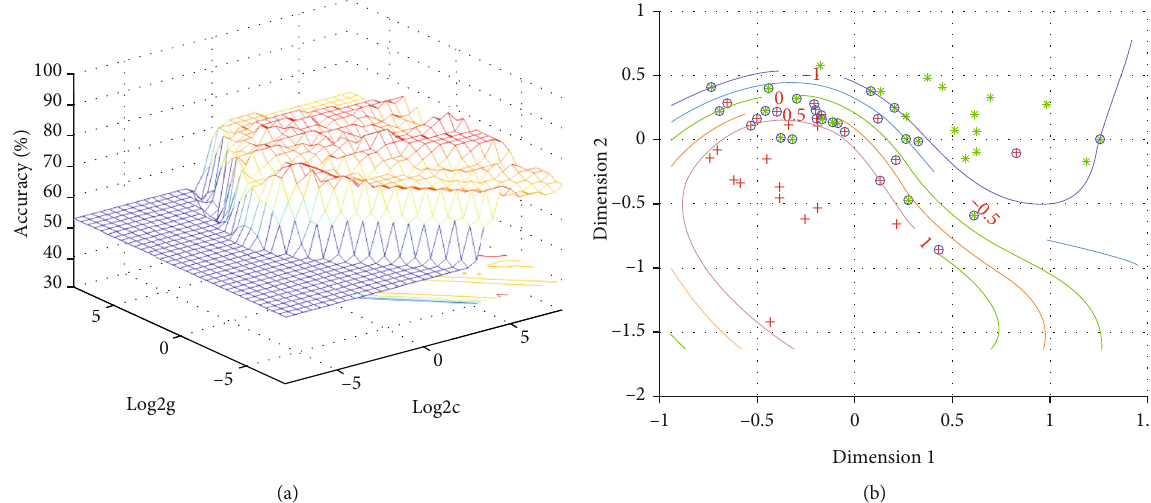
Figure 7: Visualization of classi fi cations through support vector machine (SVM) using the combination of the NH values in the left superior medial frontal gyrus and left inferior temporal gyrus. (a) SVM parameter result of 3D view. (b) Dimension 1 and dimension 2 represent the NH values in the left superior medial frontal gyrus and left inferior temporal gyrus, respectively. Red crosses represent nonmelancholic MDD patients, and green crosses represent the melancholic MDD patients. MDD: major depressive